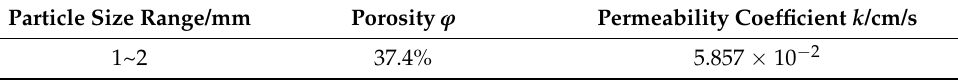
Table 1. Parameters of grouted